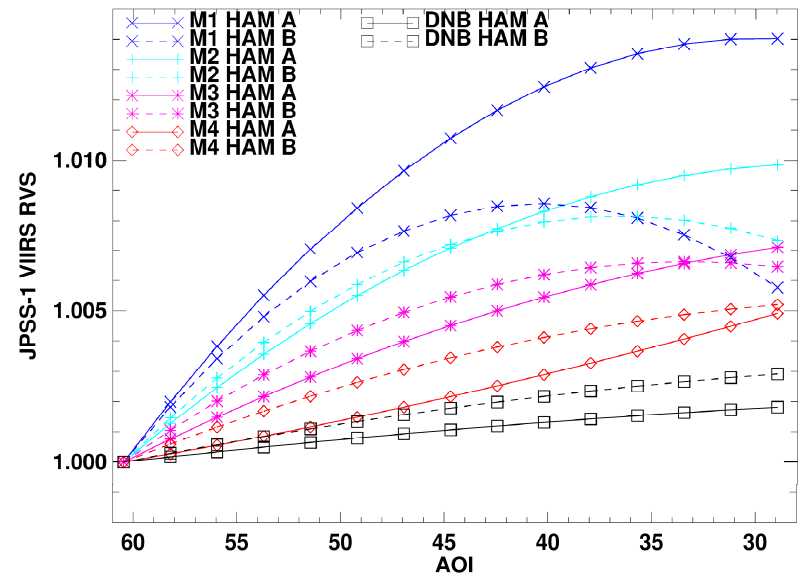
Figure 8. Band-averaged RVS for JPSS-1 VIIRS from the SV AOI to the end of scan AOI for bands M1–M4 and DNB.